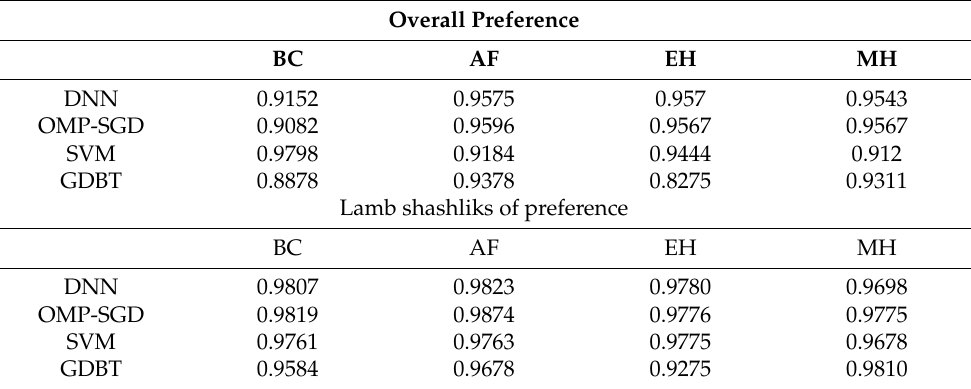
Table 4. Using machine learning methods to classify and predict the accuracy of consumers’ overall preference and lamb shashliks preference for four various cooking